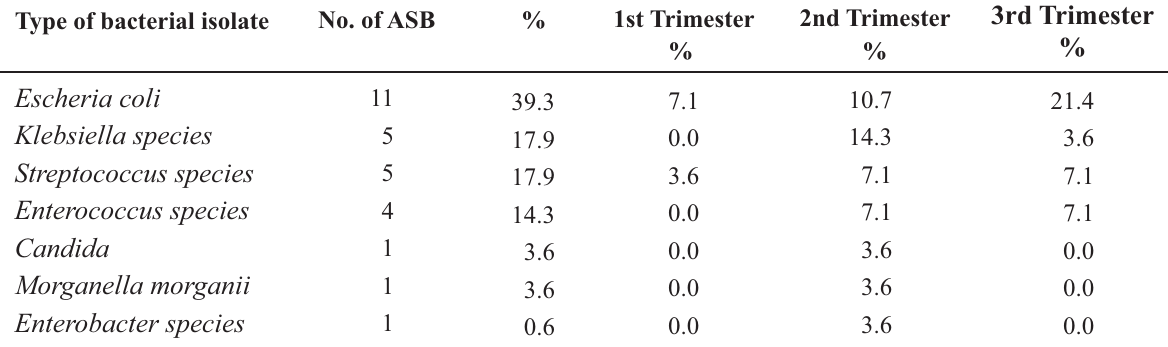
Table 3: Distribution of bacterial isolates among culture positive samples and according to trimester Type of bacterial